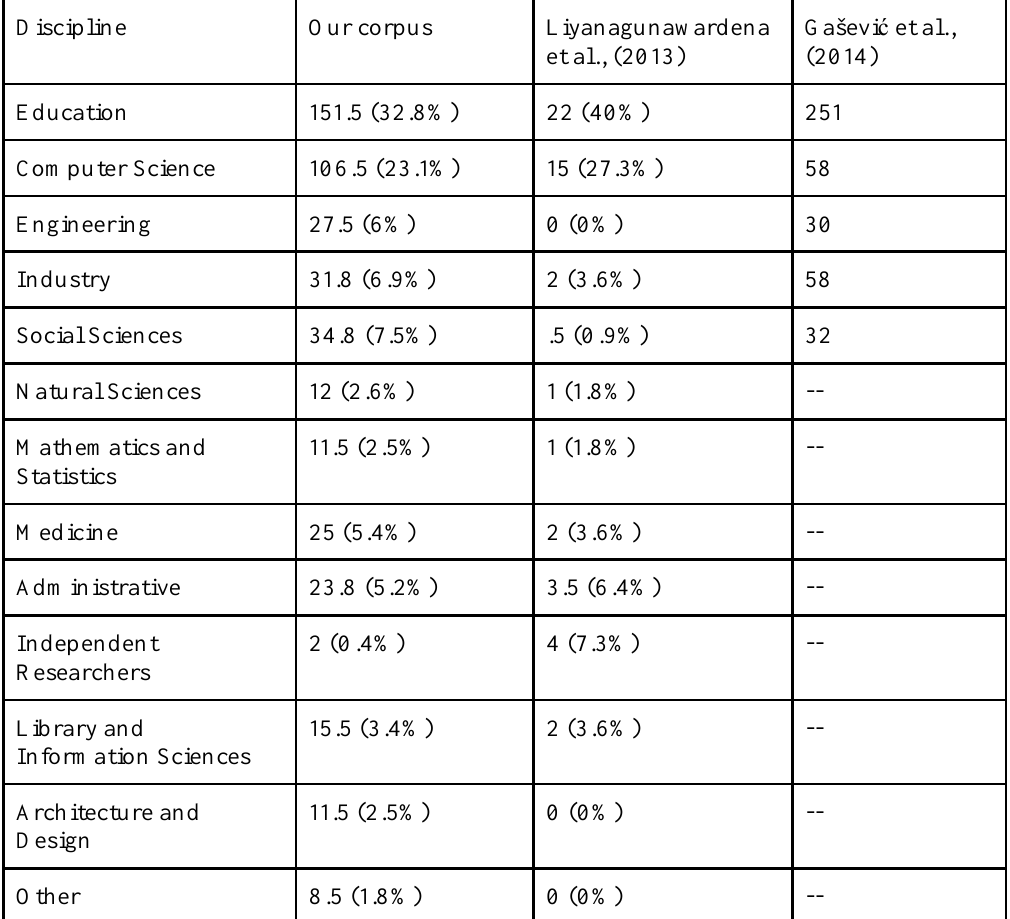
Table Notes . Decimal counts for some disciplines reflect authors whose affiliations consisted of multiple disciplines (i.e., where an author was affiliated to departments in n disciplines, each discipline had 1/ n added to its count) Numbers in parentheses represent the percentage of the relevant corpus's authors coming from that